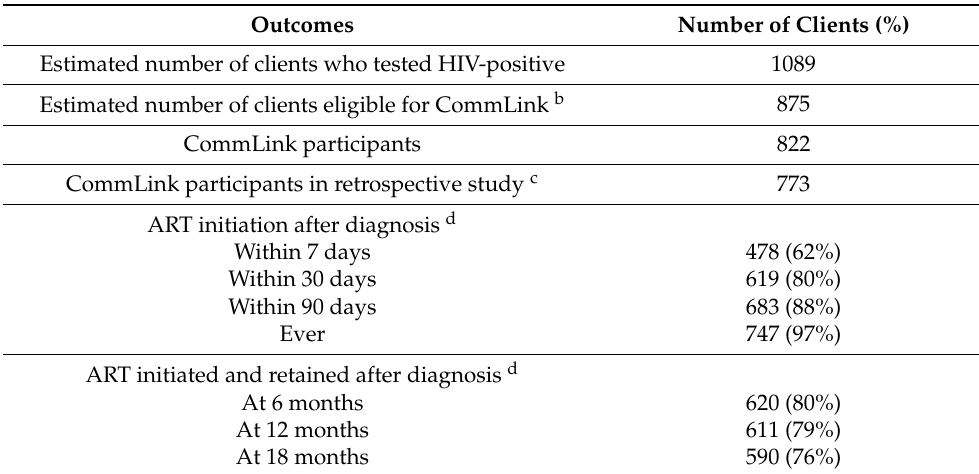
Figure 2. Total program costs by program activity (in 2018 USD). The total costs for testing, linkage, and retention services inclusive of mentoring and supervision and M&E were $542,875 (27%), $1,011,461 (51%), and $440,826 (22%), respec- tively. Table 2 presents ratios of cost per study outcome. The costs per client tested posi- tive, per client eligible for CommLink, and per CommLink participant were $499, $620, and $660, respectively. The estimated cost per client ever initiated on ART was $1354, ranging from $2114 to $1480 for clients initiated on ART within 7 – 90 days of diagnosis (Table 2). The estimated cost per client initiated and retained on ART 6 months after diag- nosis ($2343) increased slightly for clients who were initiated and retained on ART 18 months after diagnosis ($2462). Table 2. Costs per outcome (in 2018 USD).